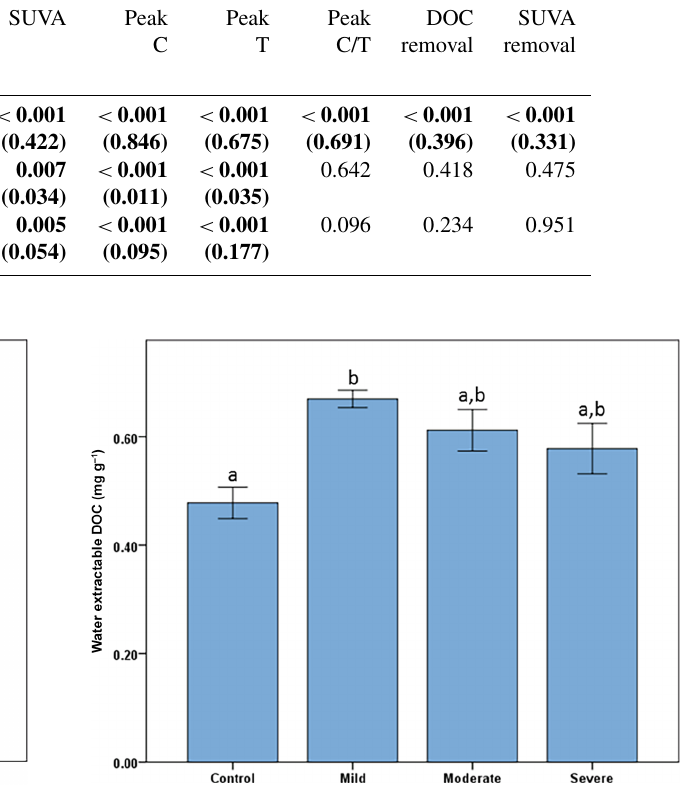
Figure 1. Water-extractable DOC of all samples across the different DOC sources ( n = 20 per source). Error bars at 1 standard error.